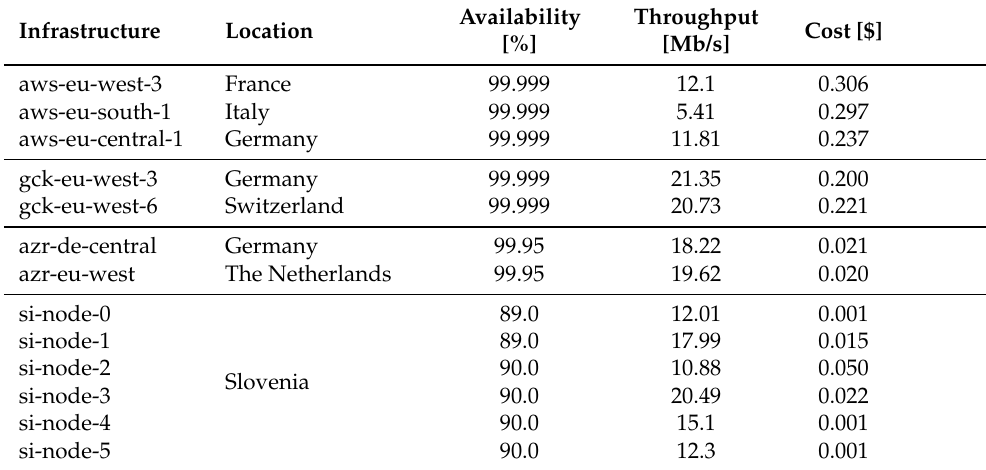
Table 2. Experimental testbed infrastructures with metrics measured from Slovenia.